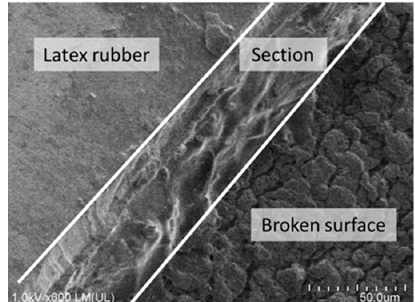
Figure 10. Scanning electron microscope (SEM)image of the line created with the bubble injector. The left area shows the surface of the latex rubber, the center area shows the surface of the cross-section, and the right area shows the broken surface of the latex rubber caused by the bubble injector.